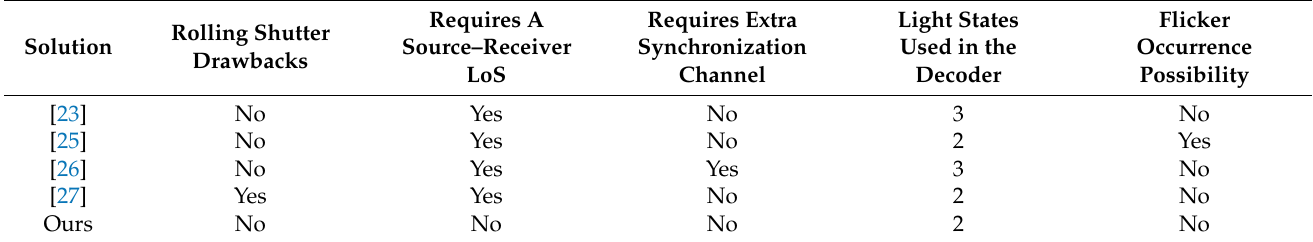
Table 4. Comparison between the proposed solution and other available OCC